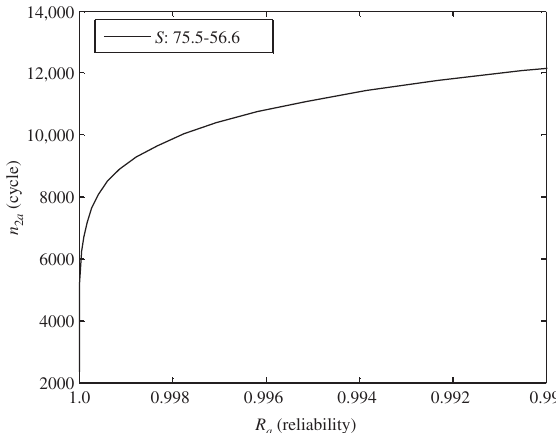
Figure 6 Typical expression of steep rise of transition period vs. R . a